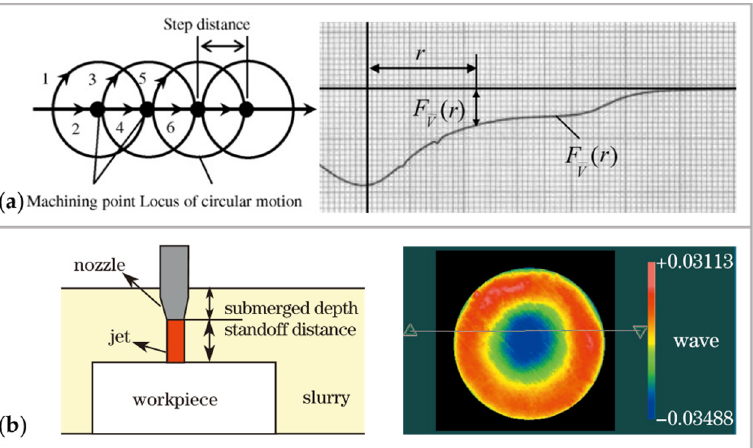
Figure 35. The FJP setup and Gaussian removal function: ( a ) Circular motion system. Reproduced with permission from [253]; ( b ) Submerged jet polishing [257].